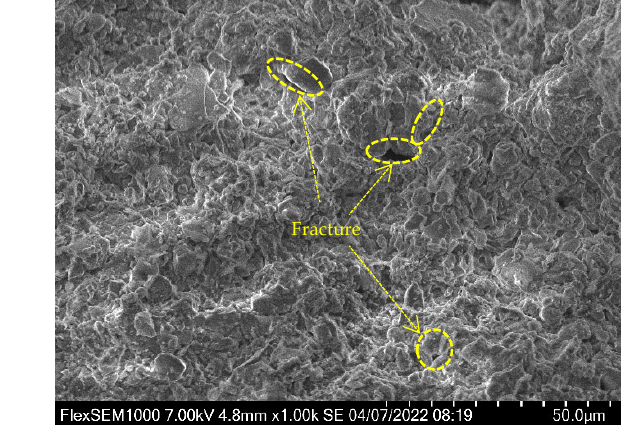
have a tendency to